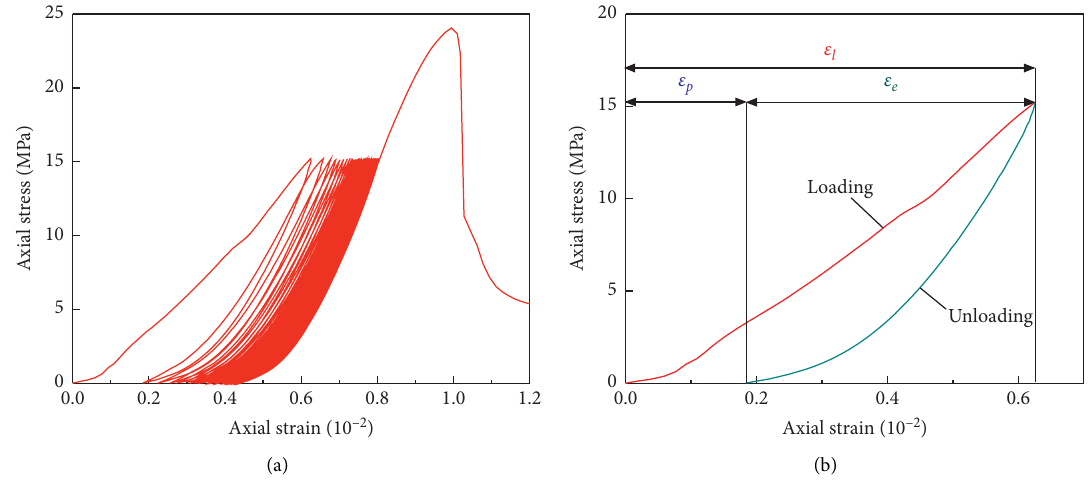
Figure 5: Typical RC curves under cyclic loading: (a) full strain curve under cyclic loading; (b) single-cycle curve.